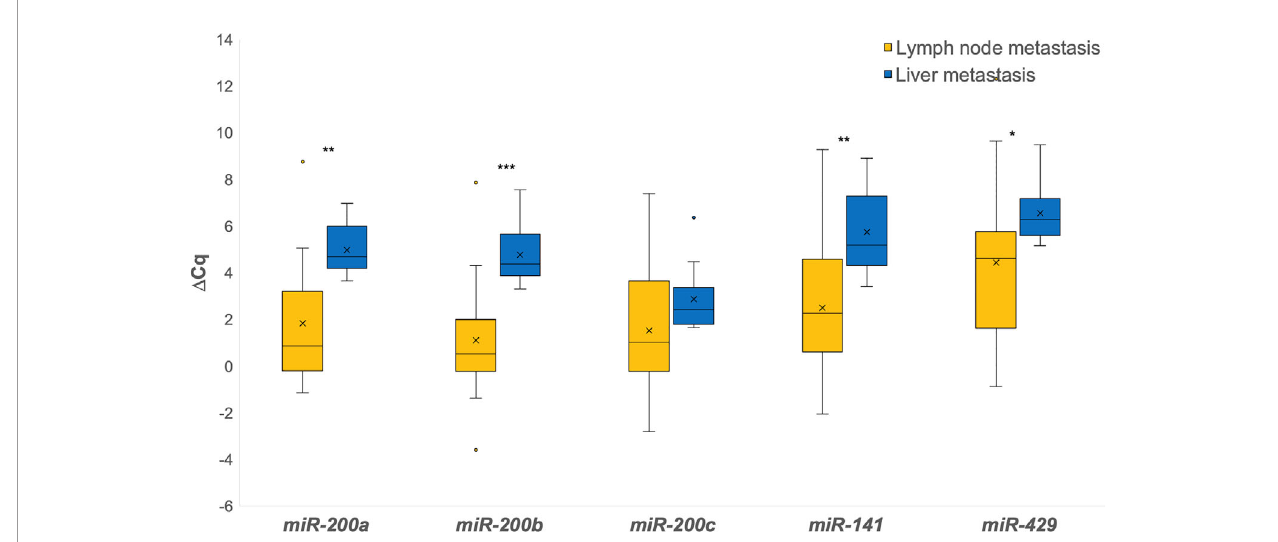
FIGURE 2 | Expression of the miR-200 family in lymph node metastases in comparison to liver metastases. *p ≤ 0.05; **p ≤ 0.01; ***p ≤